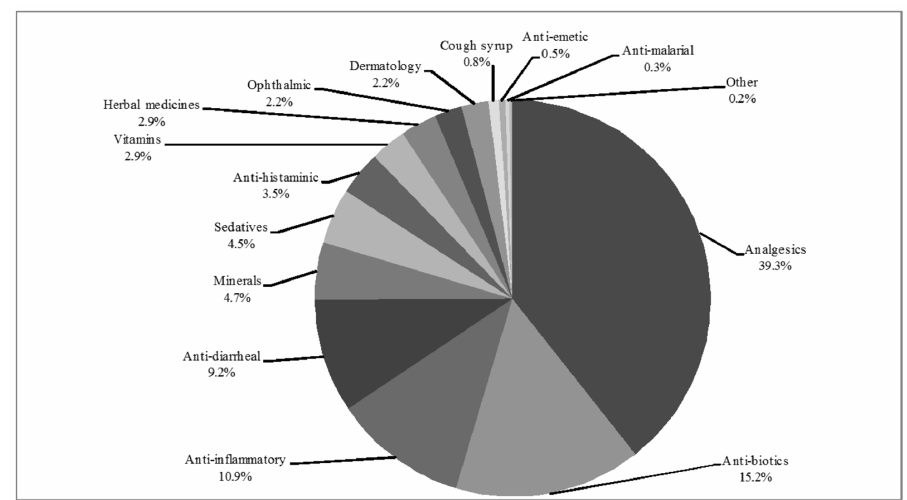
Fig 2. Sale of non-prescribed medicines. pharmacy without prescription: 1712 analgesics and antipyretics (39.4% of total), 662 antibiot-